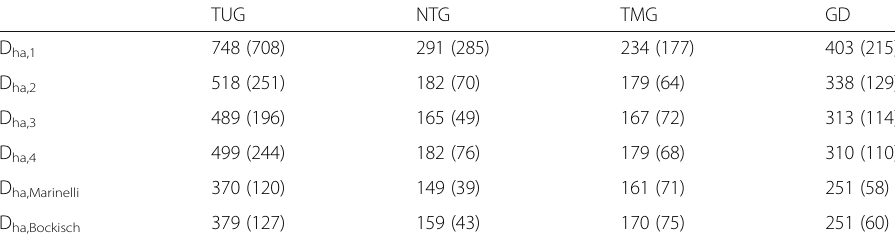
Table 3 Hypothetically achieved doses ( D ha ) for approaches 1 – 4 and activities derived from the EANM equations SOP 8 and 9 of Marinelli and Bockisch,